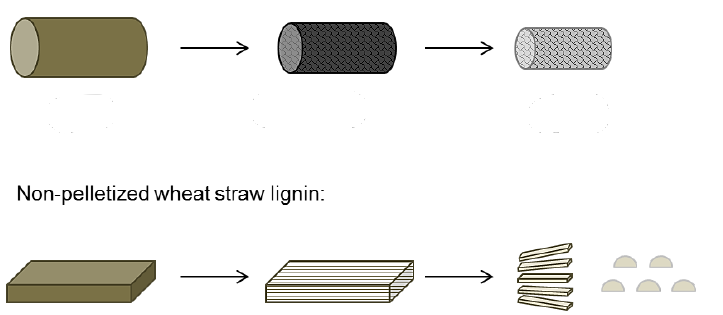
Figure 5. Simplified scheme of the conversion of pelletized and non-pelletized wheat straw lignin.